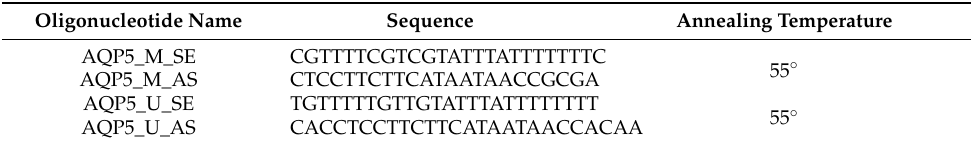
Table 3. Oligonucleotide pairs used for methylation-specific PCR.